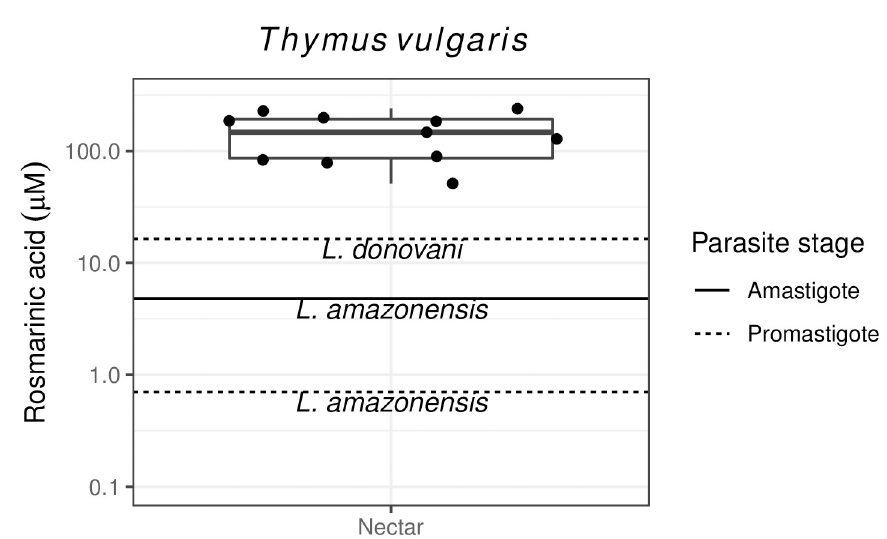
Fig 3. Concentrations of rosmarinic acid in Thymus vulgaris nectar in comparison with inhibitory concentrations for Leishmania . Points represent individual nectar samples (from [40]). Horizontal lines show published IC50 values